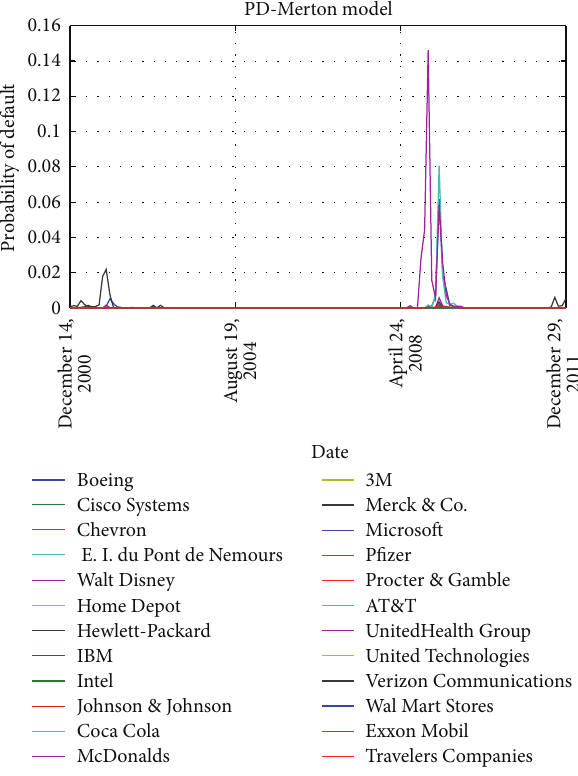
Figure 1: PDs-KMV-Merton model.